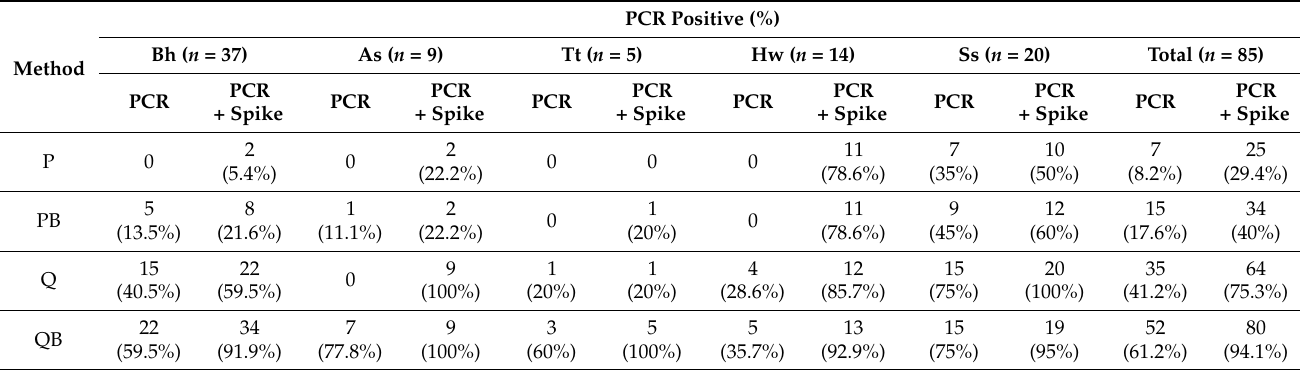
Table 3. Comparison of positive PCR rates for the detection of intestinal parasites before and after the spike tests. Bh: Blastocystis sp., As: Ascaris lumbricoides , Tt: Trichuris trichiura , Hw: hookworm, Ss: Strongyloides stercoralis